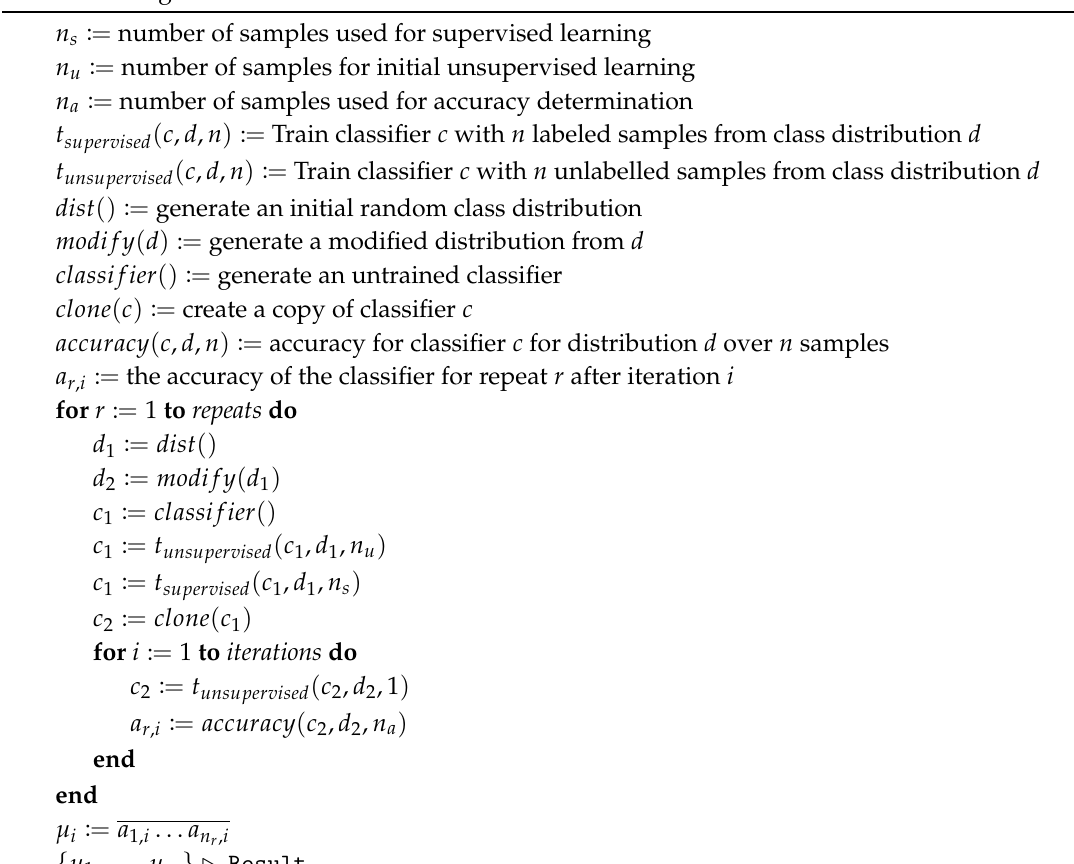
Algorithm 3: Procedure used for the simulation of QUEST to evaluate the accuracy evolution over training